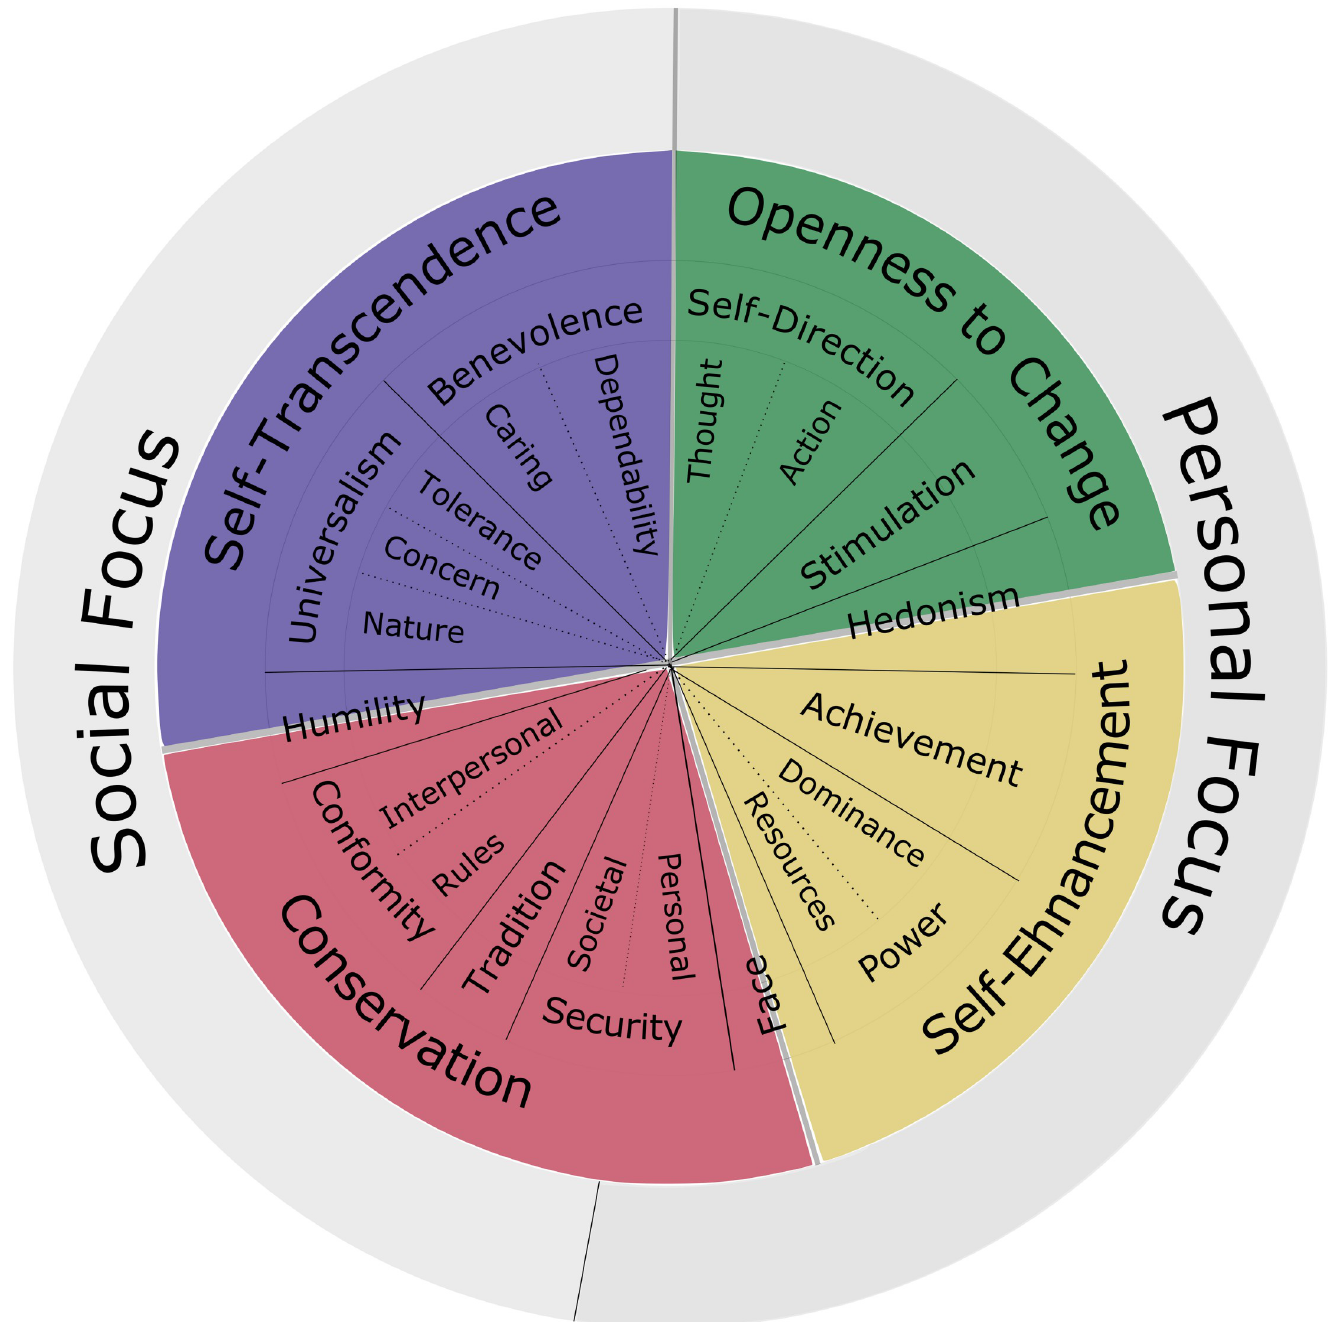
Fig 3. Circular motivational continuum source: Adapted from Schwartz et al. [21].